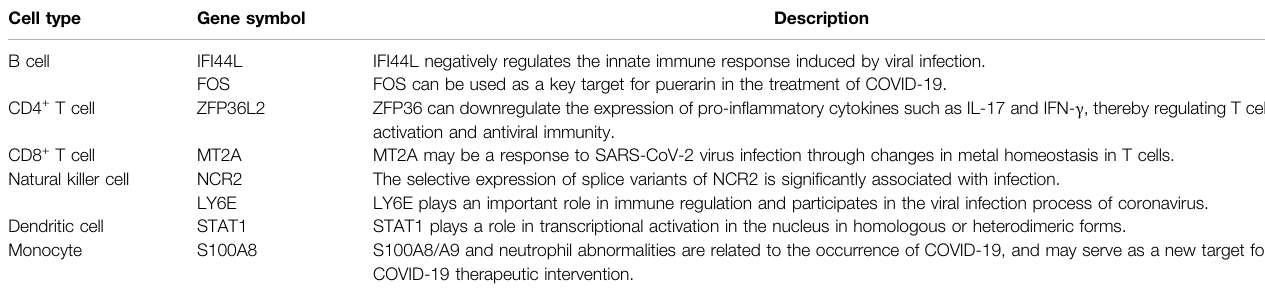
TABLE 3 | Essential identi fi ed genes for each cell